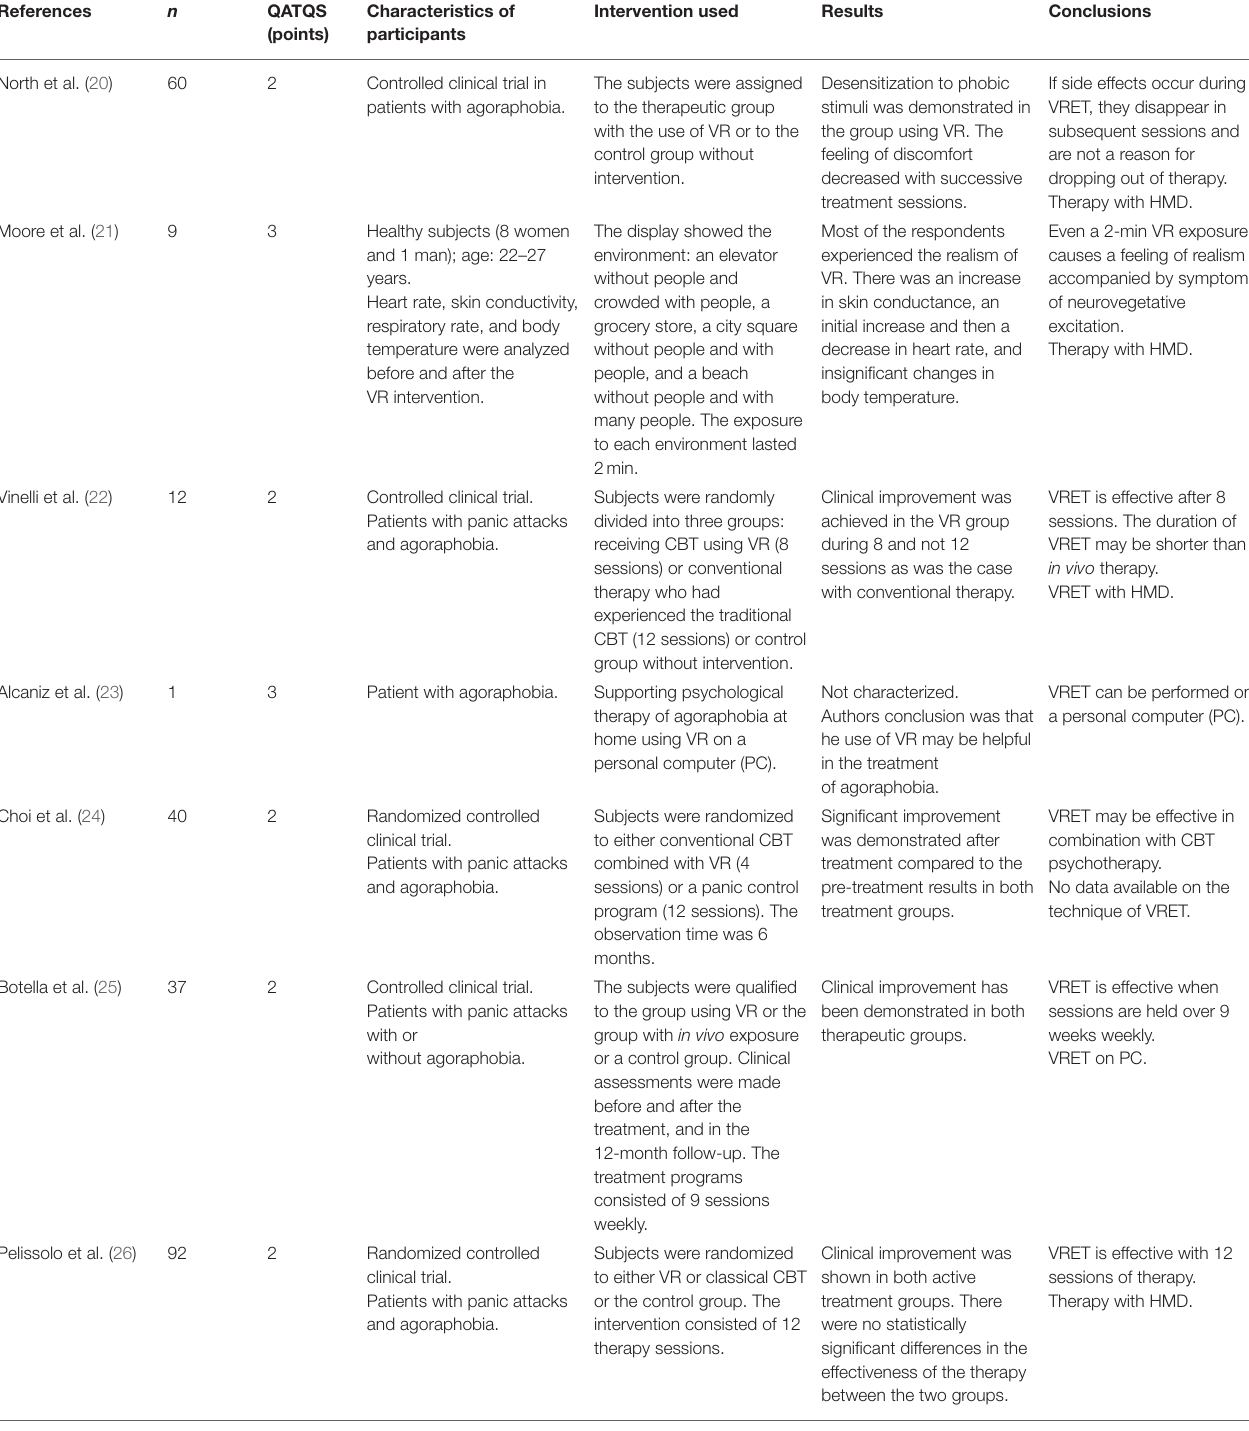
TABLE 1 | Studies on the use of VR exposure therapy in